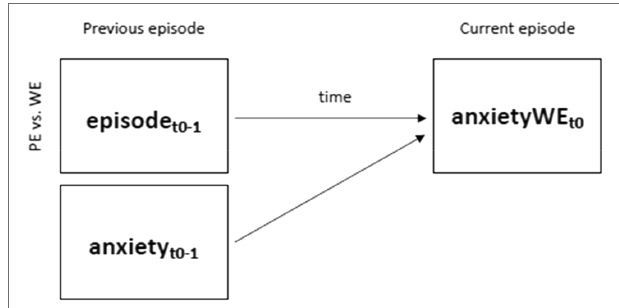
FIGURE 1 | Investigating the impact of previous episode type (i.e., positive episode vs. worry episode; t 0 ) on anxiety in a current worry episode ( t 0 ) − 1 using time-lagged models (anxiety at t 0 and time between previous and − 1 current episode was added as covariates in the model; H2a). PE = positive episode; NE = negative episode; and time = time between previous ( t 0 ) and − 1 current episode ( t 0